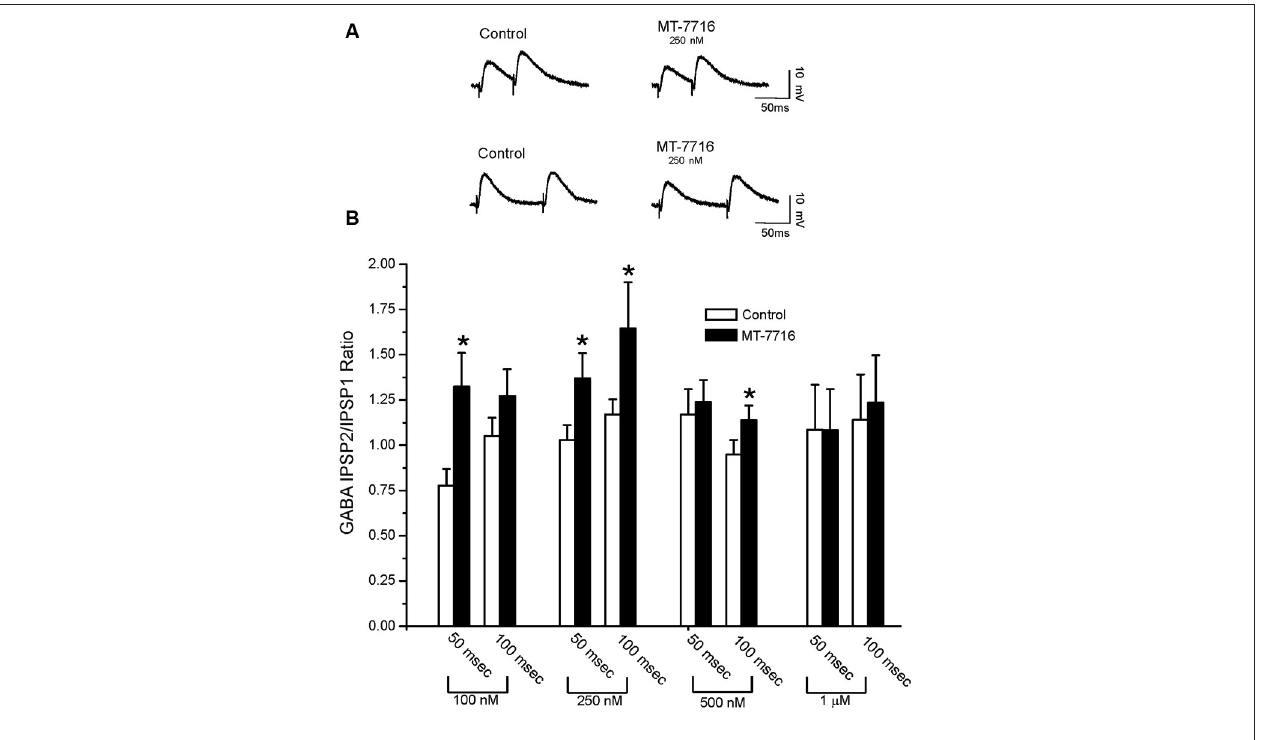
significantly increases the PPF ratio of evoked IPSPs using 50 ms interstimulus intervals. MT-7716 (250 and 500 nM) significantly increases the PPF ratio of evoked IPSPs using 100 ms interstimulus intervals. (*) Indicates ( p < 0.05) after appropriate Post-hoc Newman-Keuls